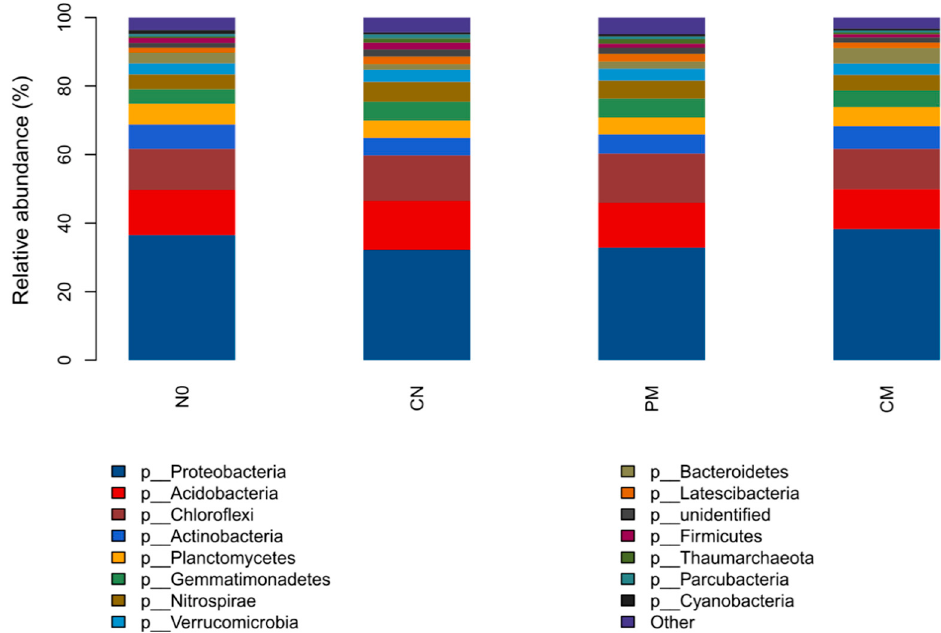
Figure 2. The relative abundances of dominant prokaryotic phyla in four kinds of organic materials amendment. Data were means of three replicates of composite samples. NO: no N fertilizer. CN: 100% urea N with no organic fertilizer. PM: 80% urea N plus 20% N with pig manure. CM: 80% urea N plus 20% N with